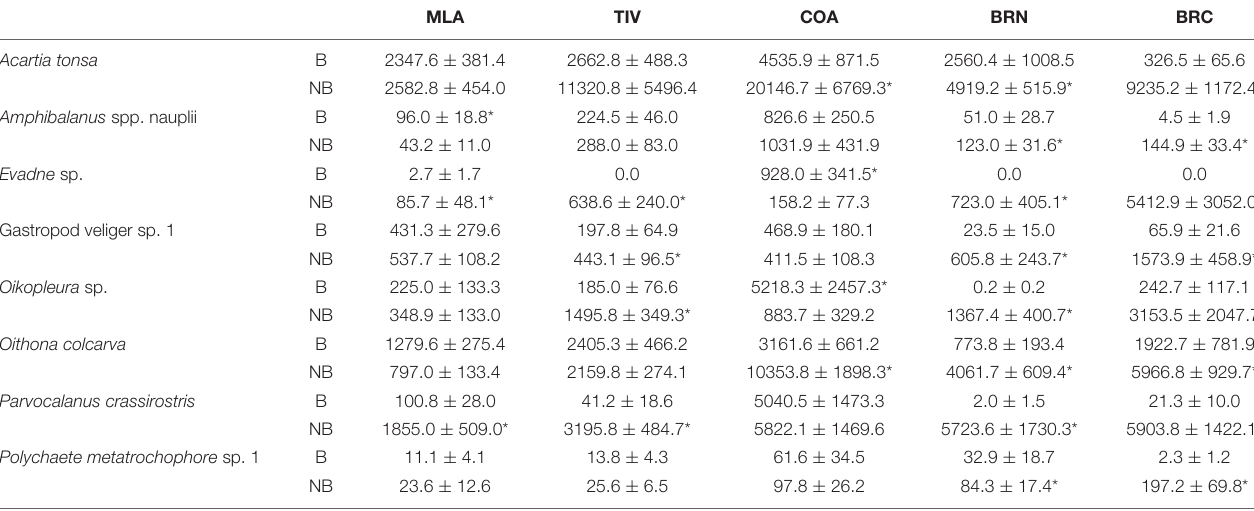
TABLE 2 | Key grazer densities (ind. m − 3 ) at each site during known bloom (B) and non-bloom (NB) conditions. MLA TIV